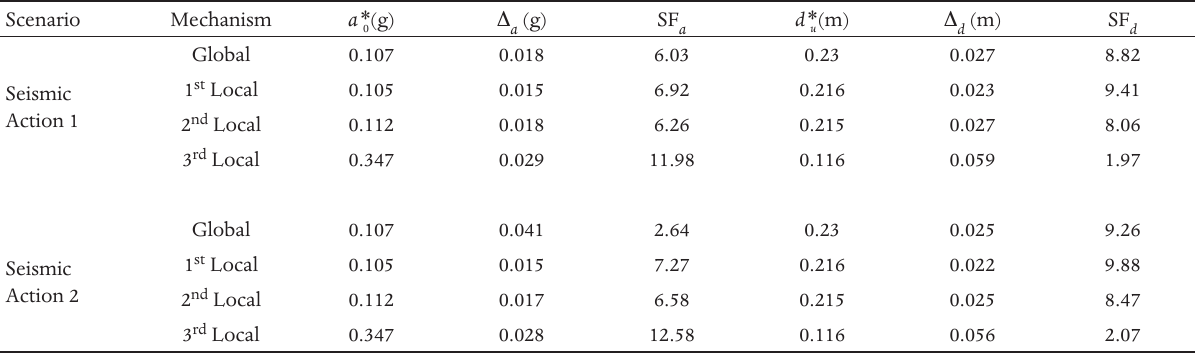
Table 8. Comparison between seismic capacity and seismic demand. (Δ is the acceleration seismic demand; Δ a